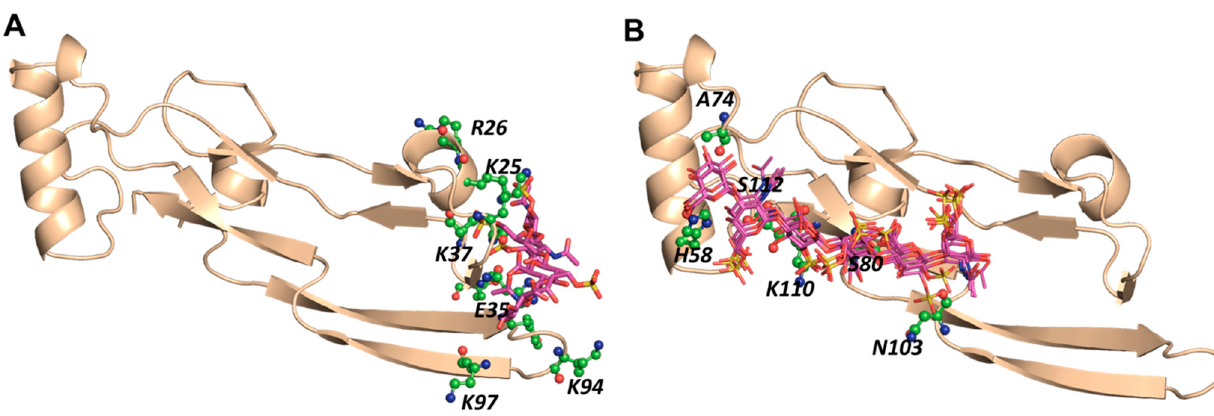
Figure 5. CVLS-predicted hexasaccharide sequences from the ∆ UA NRE , GlcA NRE , and GlcN NRE libraries of CS that prefer to bind to ( A ) BS1 and ( B ) BS2 of TGF- β 2 (magenta and blue color by atom sticks, respectively). See text for details.